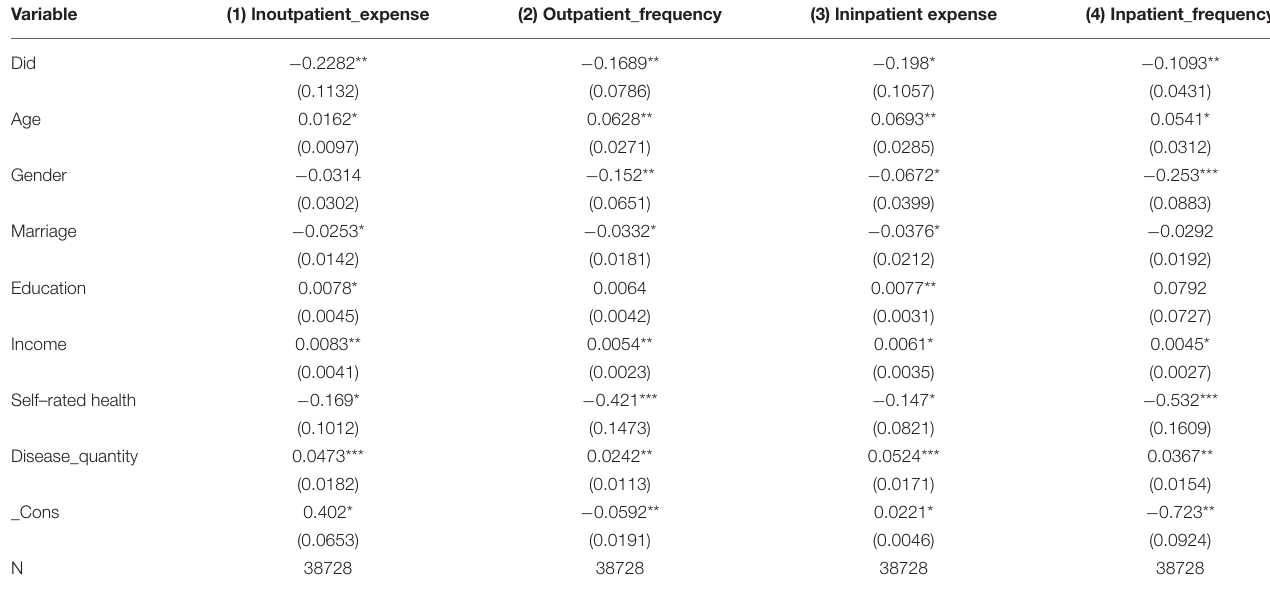
TABLE 4 | DID regression results of the expenses and frequency of the medical